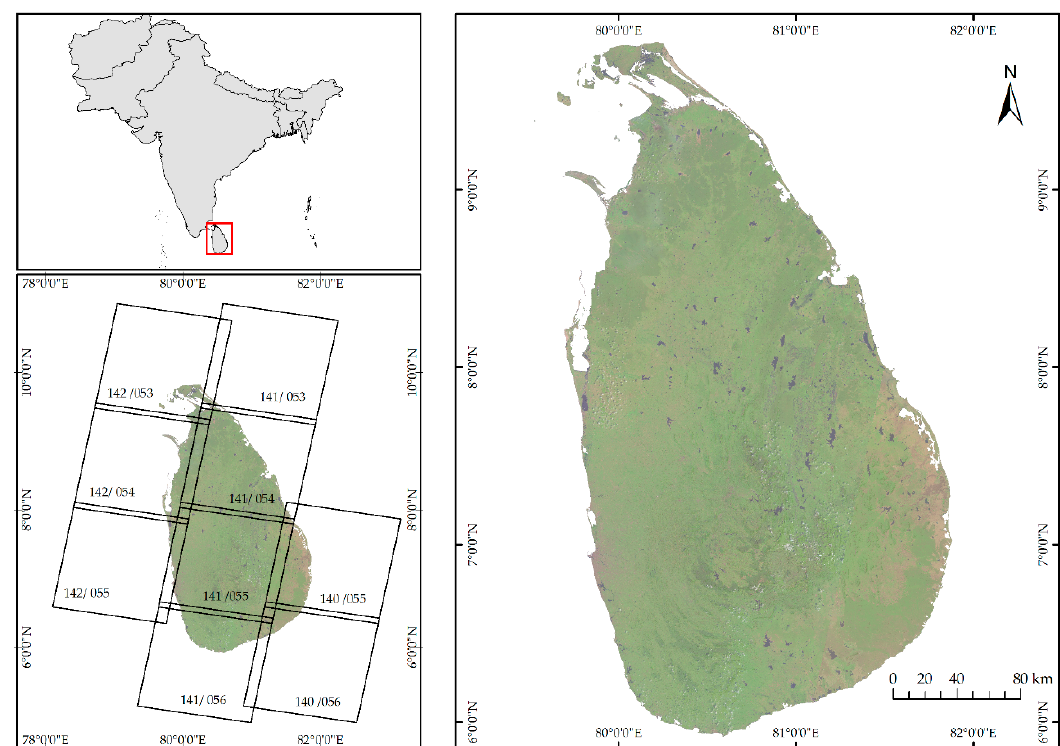
Figure 1. Location of study area (top left—location of Sri Lanka in South Asia; bottom left—Landsat tiles (142/053, 142/054, 142/055, 141/053, 141/054, 141/055, 141/056, 140/055,140/056) of Sri Lanka; right, a composite image of Sri Lanka, 2017, coordinate reference system (CRS) WGS 84-UTM Zone 44N.